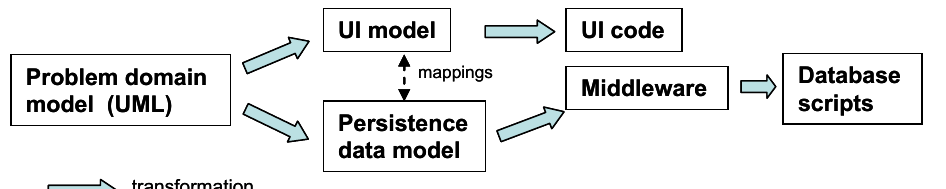
Figure 6. The development process using the EUIS profile is based on transformations. Reproduced with permission from [5], copyright IEEE,